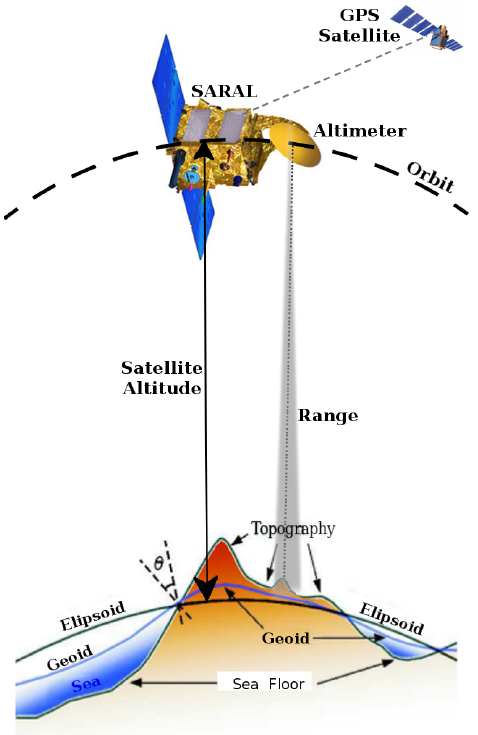
Figure 1: Illustration of the principle of satellite altimetry with